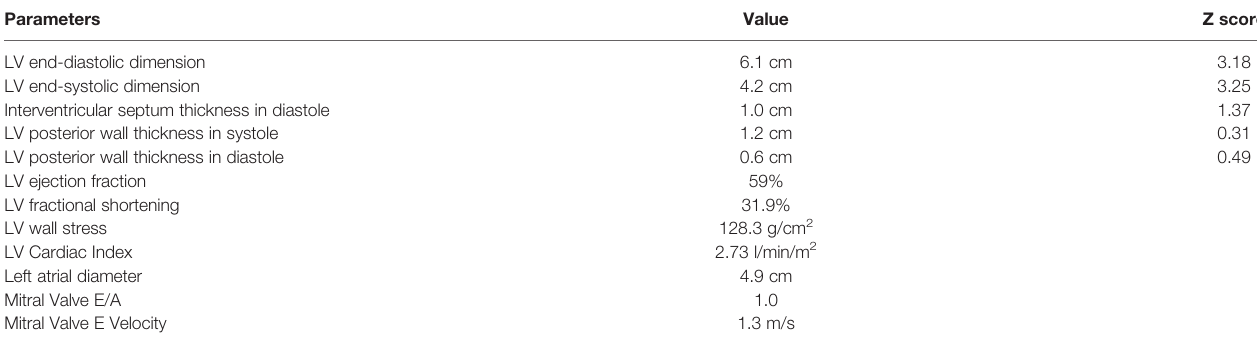
TABLE 2 | Key Echocardiogram parameters. Parameters